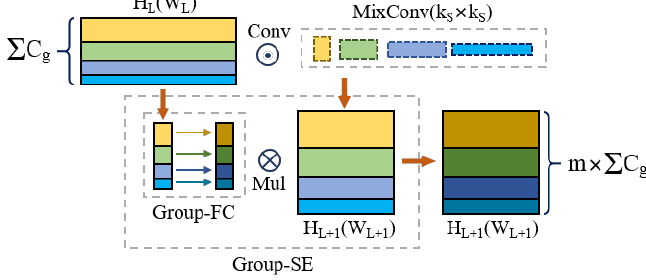
Figure 3. Mixed convolutional module for feature extraction.